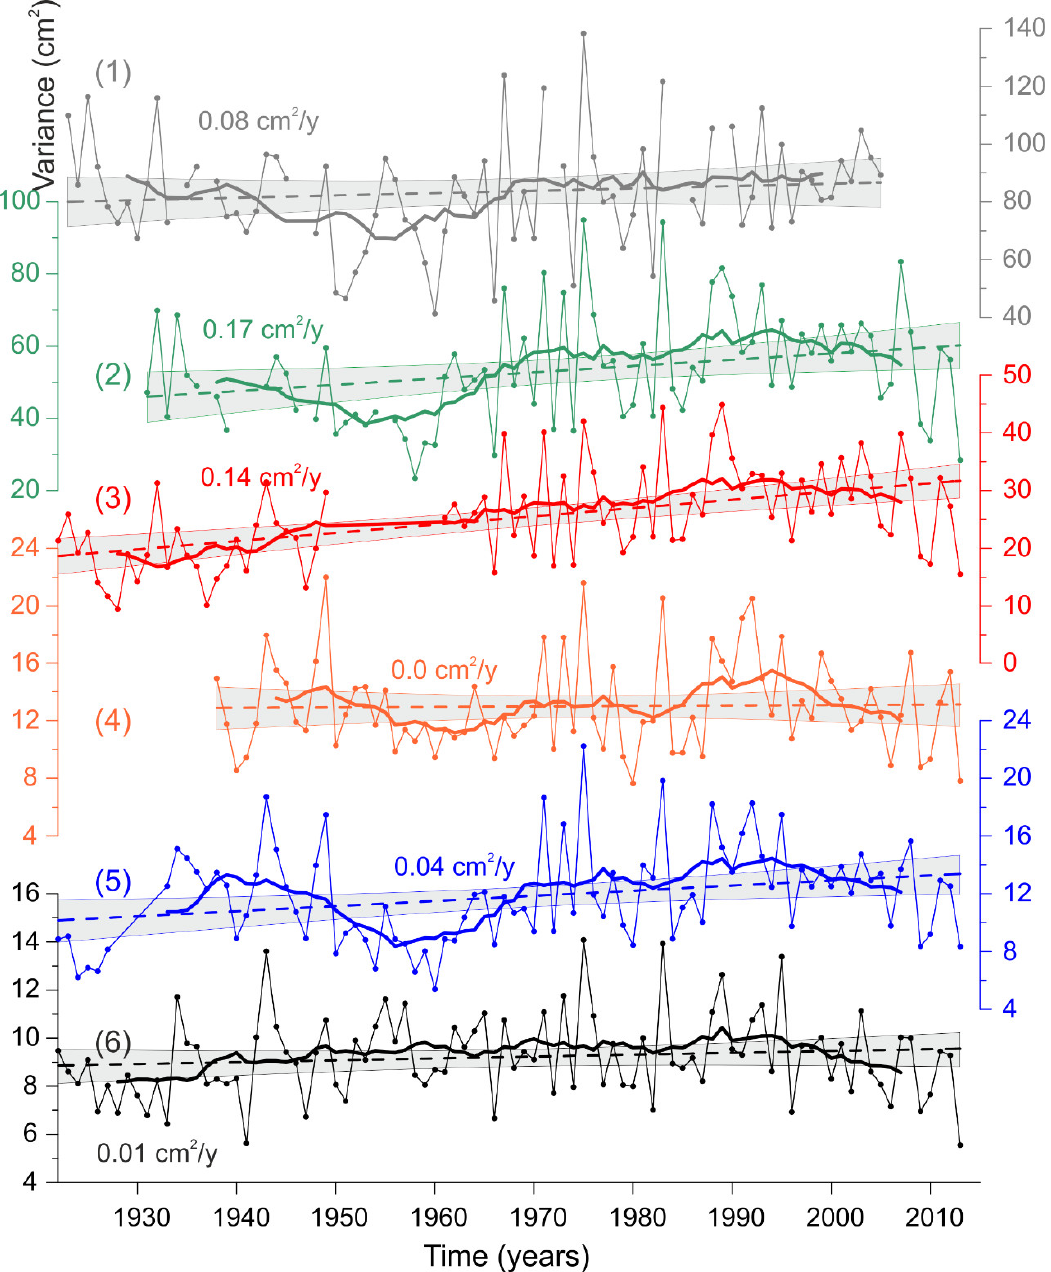
Figure 8. Interannual changes of the mesoscale Baltic Sea level oscillation variance at stations (1) Gedser, (2) Klagshamn, (3) Kungsholmsfort, (4) Furuogrund, (5) Ratan, and (6) Stockholm. The dashed line shows the long-term linear trends with 95% confidence intervals (the lighter shaded area); the bold solid line shows the 13-year moving average for the corresponding stations.